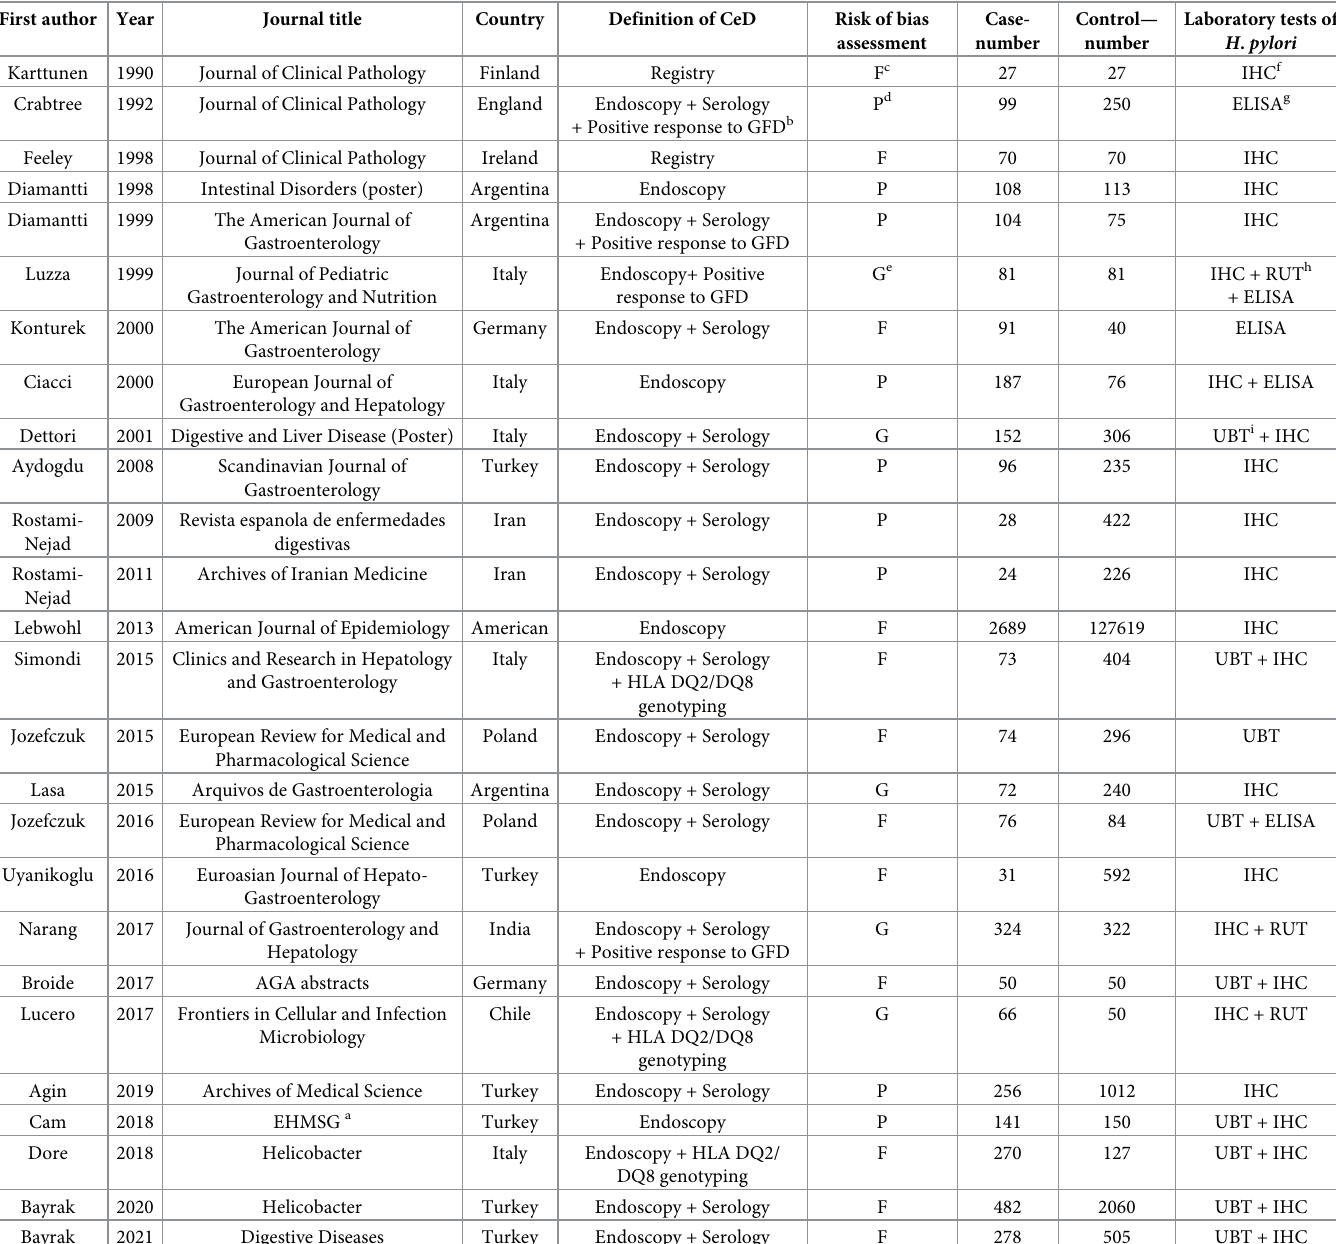
Table 1. Main characteristics of the included studies in the meta-analysis on the Helicobacter pylori infection and celiac disease